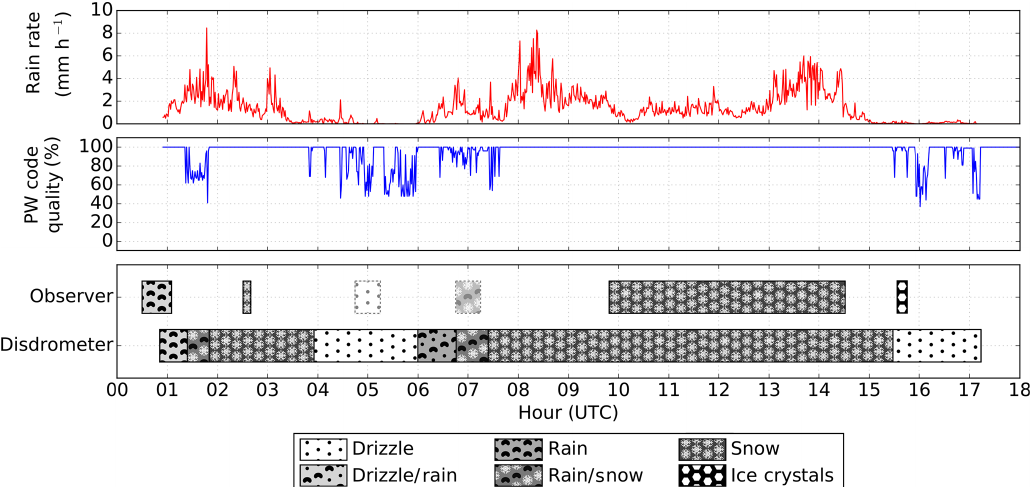
Figure 8. Rain rate, hydrometeor type, and present weather code quality index during the storm Doris event on 23 February 2017, which occurred over approximately 16h at Gladhouse Reservoir, Scotland. Rain rate is liquid equivalent for periods of snow and is recorded by a Thies LPM disdrometer. Hydrometeor type is shown from both the disdrometer and impromptu from a trained meteorologist. The meteorologist observations at 05:00 and 07:00UTC are approximate due to a lack of accurate time information. The disdrometer misidentified individual ice crystals at 15:39 as